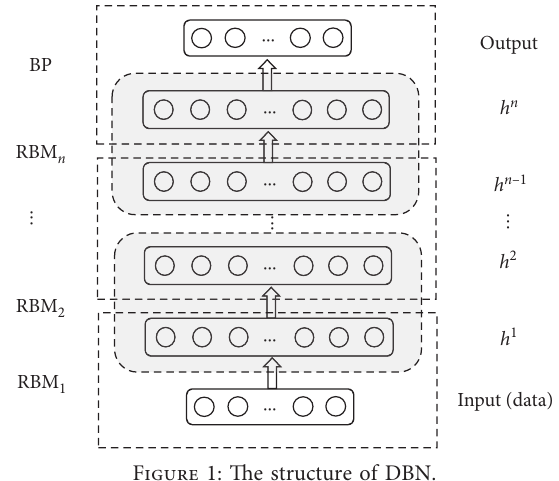
Figure 1: The structure of